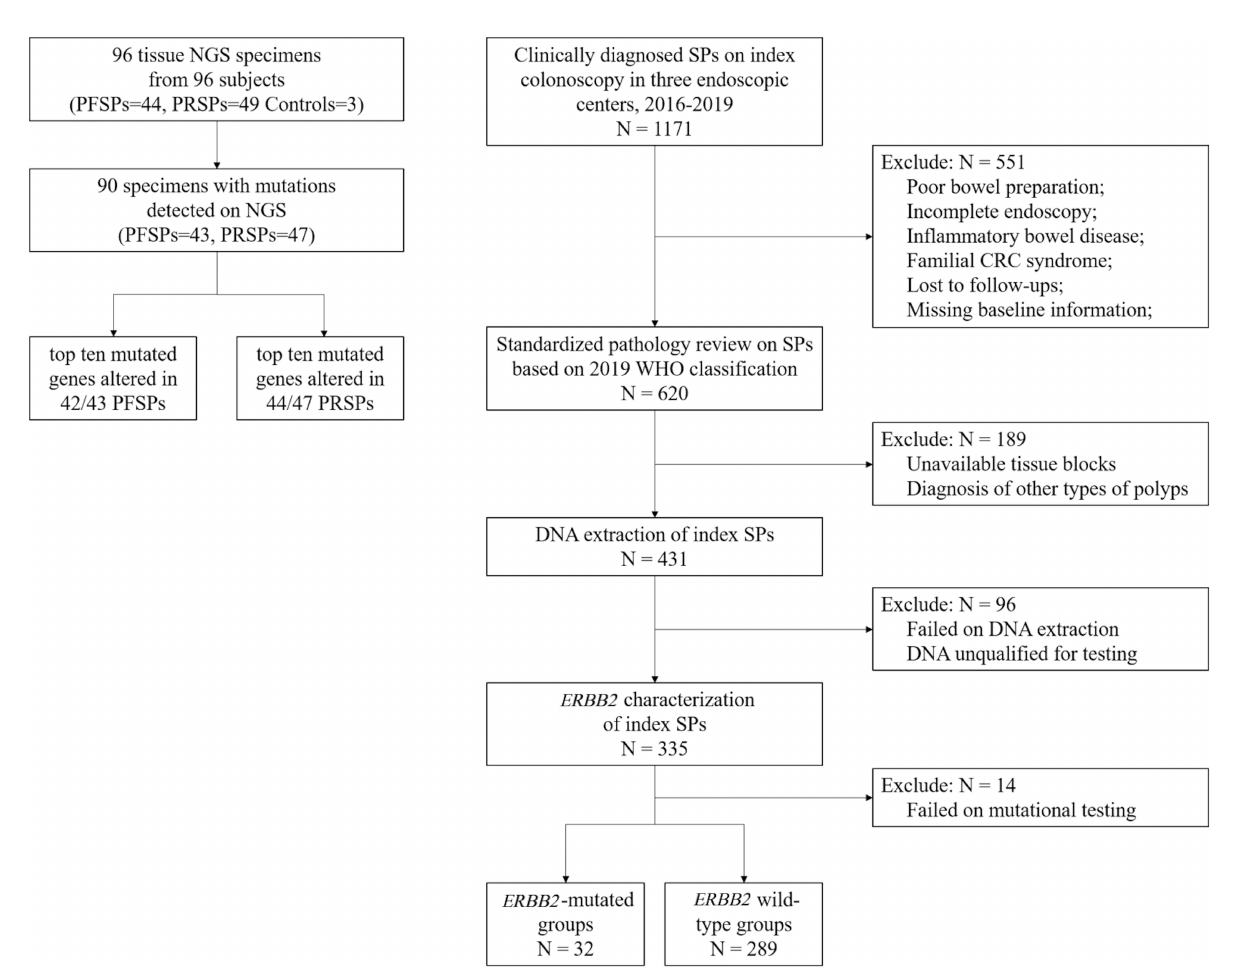
FIGURE 1 | Cohort fl owchart. NGS, next generation sequencing; PRSPs, polyp-relapsed serrated polyps; PFSPs, polyp-free serrated polyps; SPs, serrated polyps; CRC, colorectal